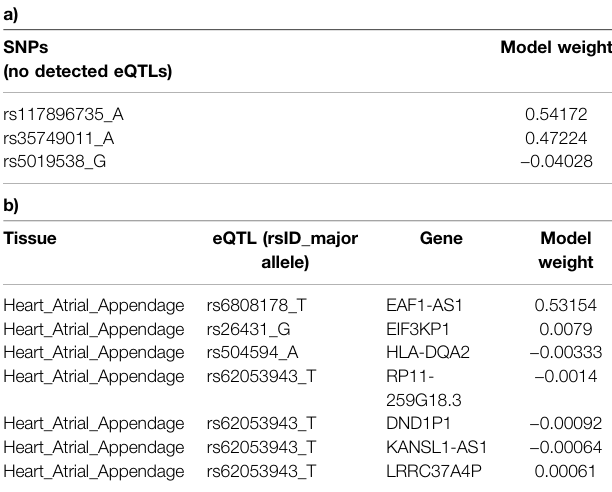
TABLE 2 | SNPs identi fi ed as being the main contributors to model-2. a) SNPs with no detected eQTL effects, and b) eQTL effects within the Heart Atrial Appendage. The model weight is the coef fi cient assigned to each variant or eQTL in the logistic regression predictor